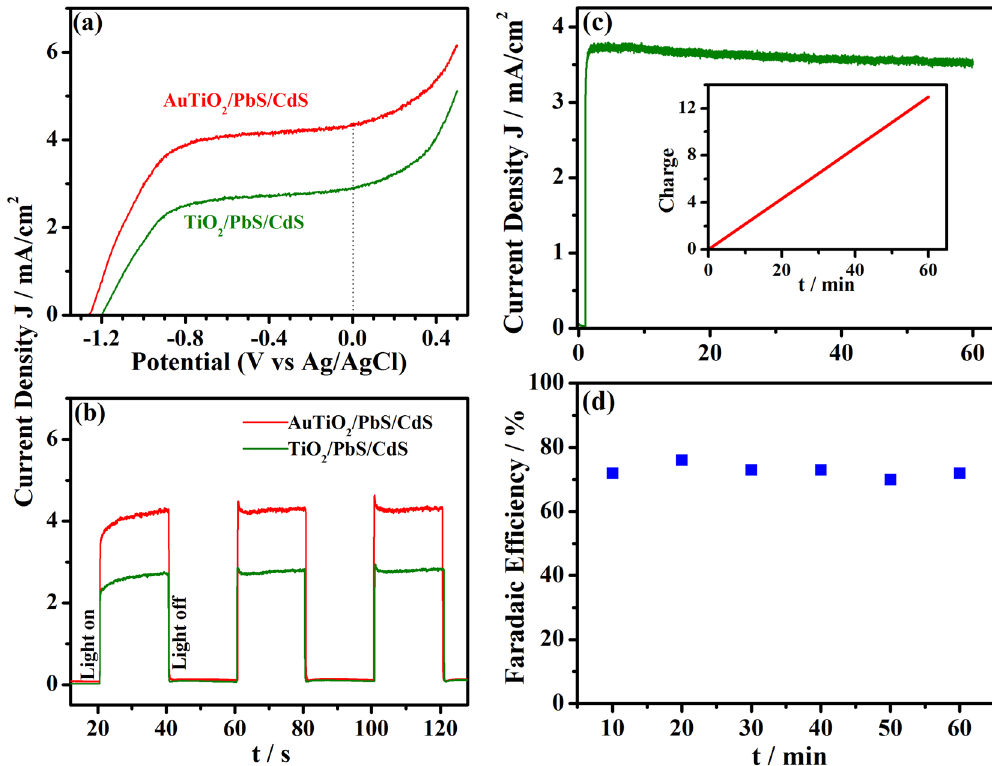
Figure 4. Photoelectrochemical performance of the AuTiO 2 /PbS/CdS and TiO 2 /PbS/CdS photoanode under one sun illumination. ( a ) j-V curves obtained under linear sweep voltammetry; ( b ) Chronoamperometry measurement at 0 V. ( c ) Chronoamperometric measurement shows the stability of photoanode for 1 h in the wired configuration. The inset demonstrates the amount of charge passed through the external circuit for 1 h. ( d ) Faradaic efficiency of the process calculated by comparing the amount of charge passed through the circuit and the amount of H 2 gas